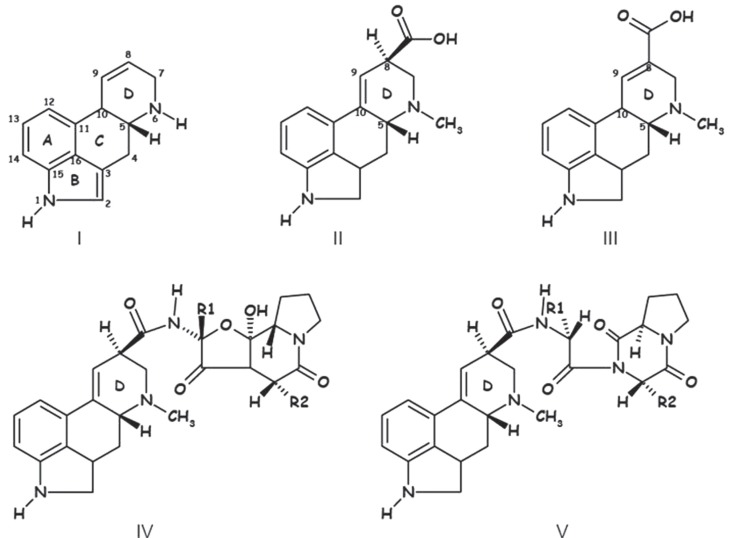
Chemical structure of ergoline (I), lysergic acid (II) paspalic acid (III) ergopeptines (IV), and lactam ergot alkaloids – ergopeptams (V) (35).